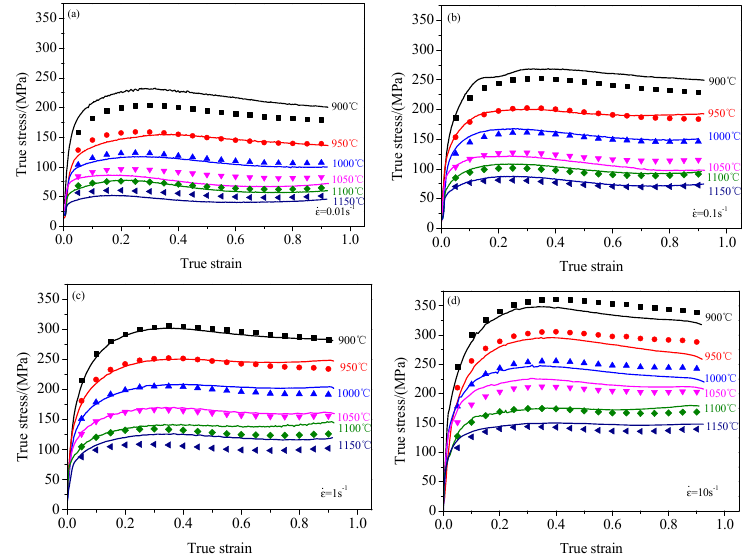
Figure 6. Predicted flow curves and its comparison with those experimentally obtained at strain rates of ( a ) 0.01 s − 1 , ( b ) 0.1 s − 1 , ( c ) 1 s − 1 and ( d ) 10 s − 1 in the deformation temperature range of 900–1150 °C.